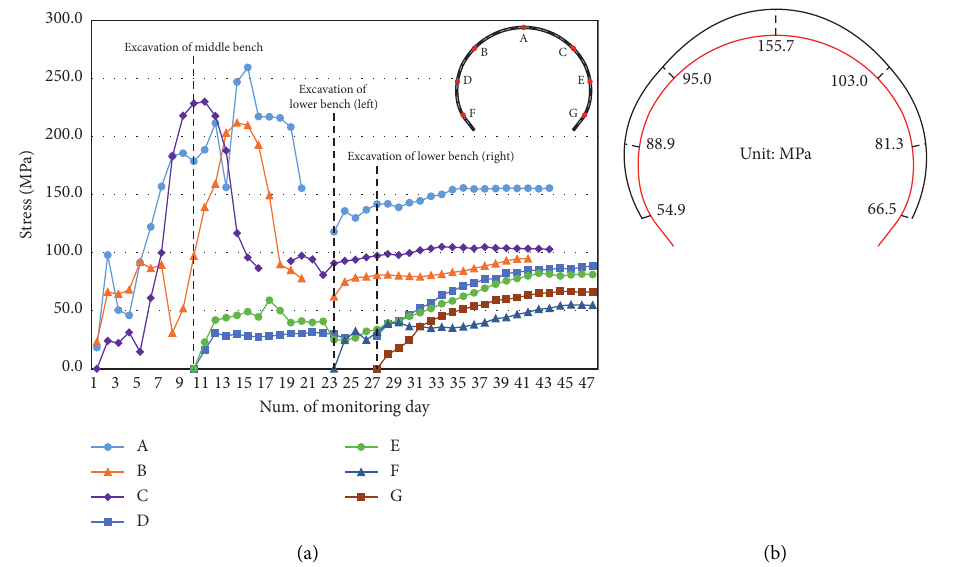
Figure 13: (a) Time-history curve and (b) spatial distribution of steel arch stress at Z5K64+500. The spatial distribution diagrams were based on the last data of the time-history